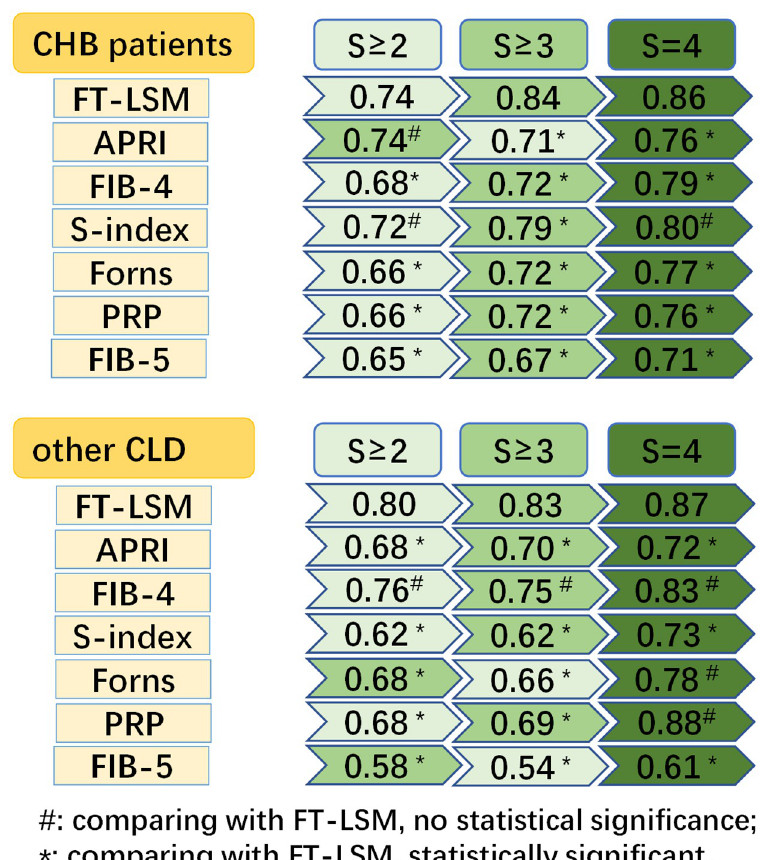
Fig 3. AUROC between CHB patients and other CLD patients among different fibrosis stage to FibroTouch and six serological models. FT-LSM: FibroTouch liver stiffness; APRI: Aspartate transaminase-to-platelet ratio index.